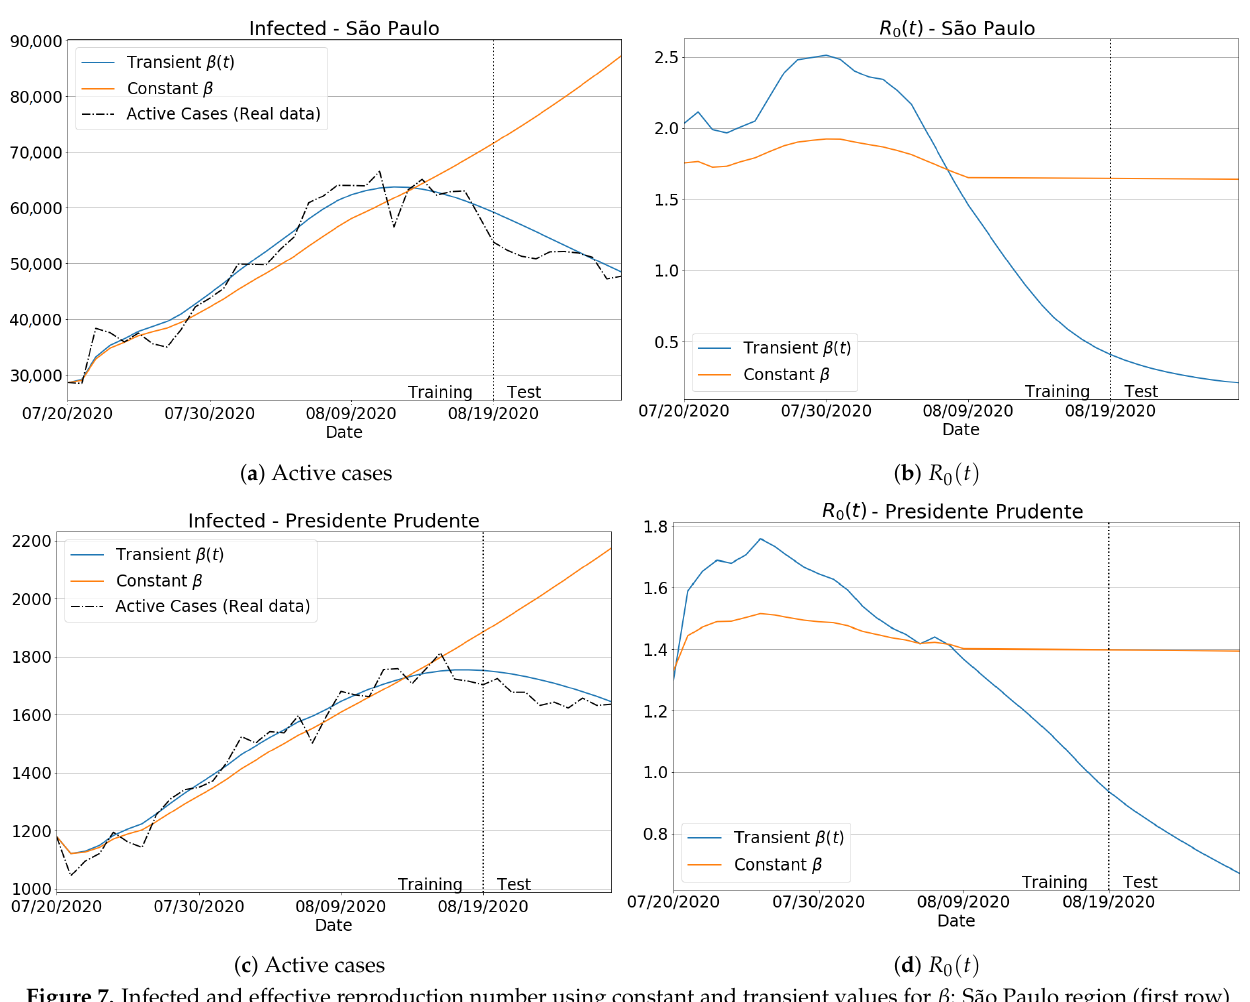
Figure 7. Infected and effective reproduction number using constant and transient values for β : São Paulo region (first row) and Presidente Prudente region (second